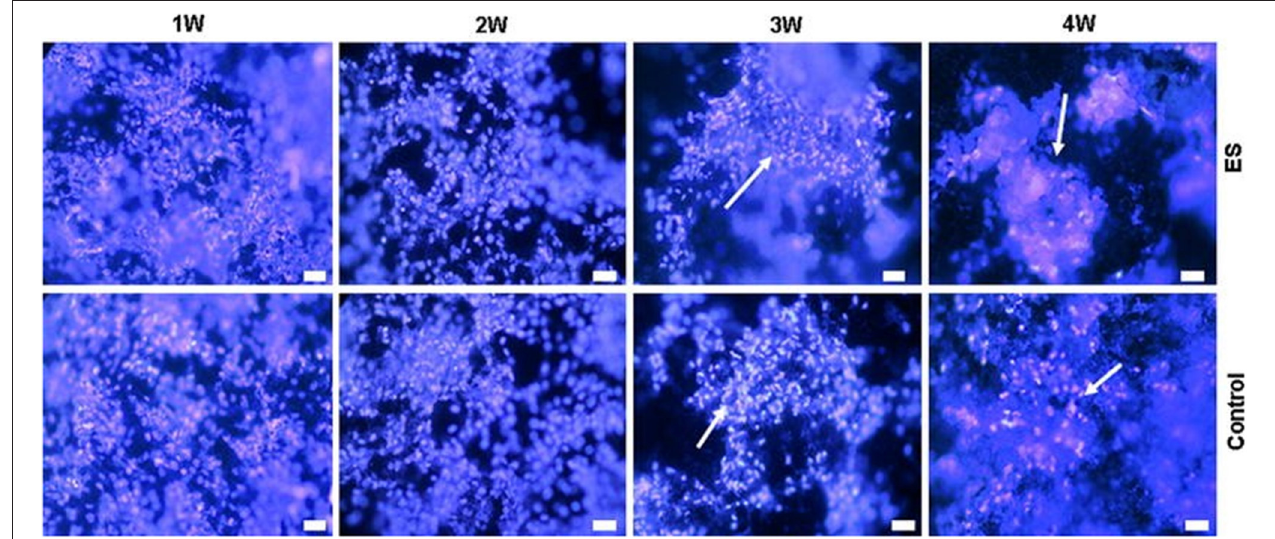
FIGURE 2 | Electrical stimulation study on Saos-2 cells on PLLA/PPy/HE membranes. The arrowheads show the formation of nodules in the highest periods (Hoechst staining, bar 10 µ m). Adapted from ( 65) with permission from the